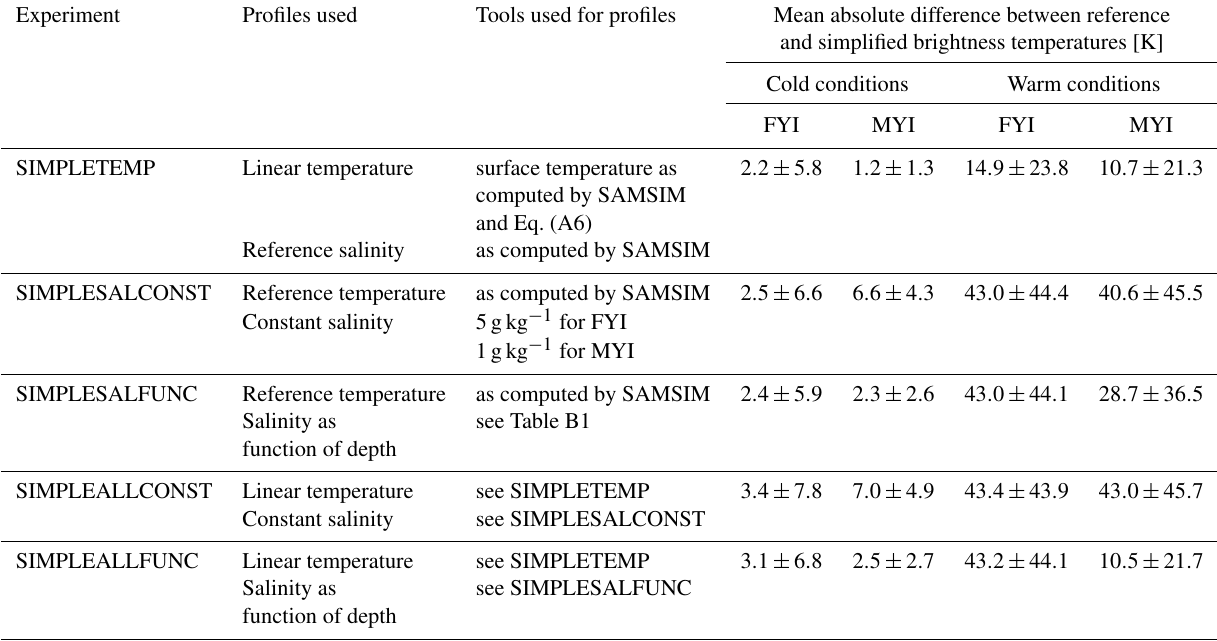
Table 2. Summary of the results of the experiments investigating the effect of simplifying temperature and salinity profiles on the brightness temperature simulation. See Sect. 4.2 for more information. Experiment Profiles used Tools used for profiles Mean absolute difference between reference and simplified brightness temperatures [K] Cold conditions Warm conditions FYI MYI FYI MYI SIMPLETEMP Linear temperature surface temperature as and Eq. (A6) Reference salinity as computed by SAMSIM Reference temperature as computed by